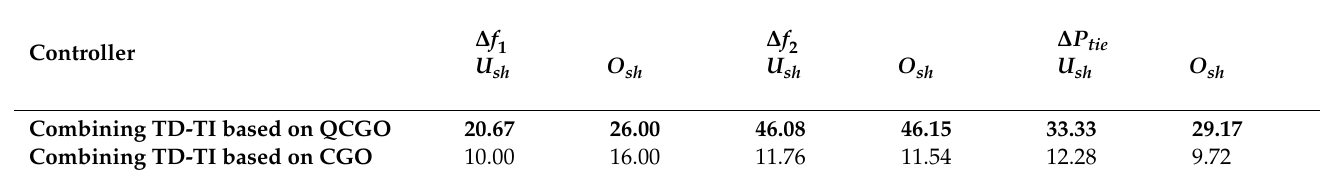
Table 17. Percentage improvement in U sh and O sh values for combining TD-TI/QCGO and combin- ing TD-TI/CGO based on combining TD-TI/SSA for scenario